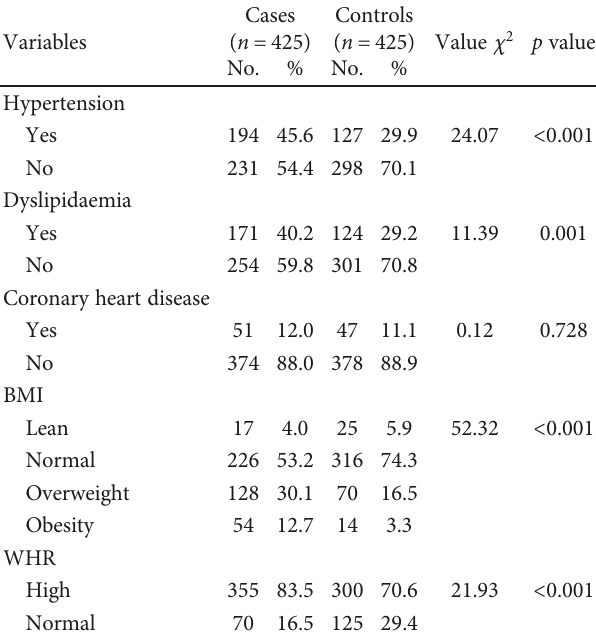
Table 3: Physiological features and other chronic diseases among the